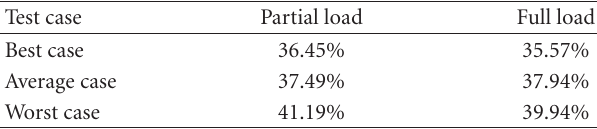
Table 6: Monte-Carlo analysis with the NN controller.